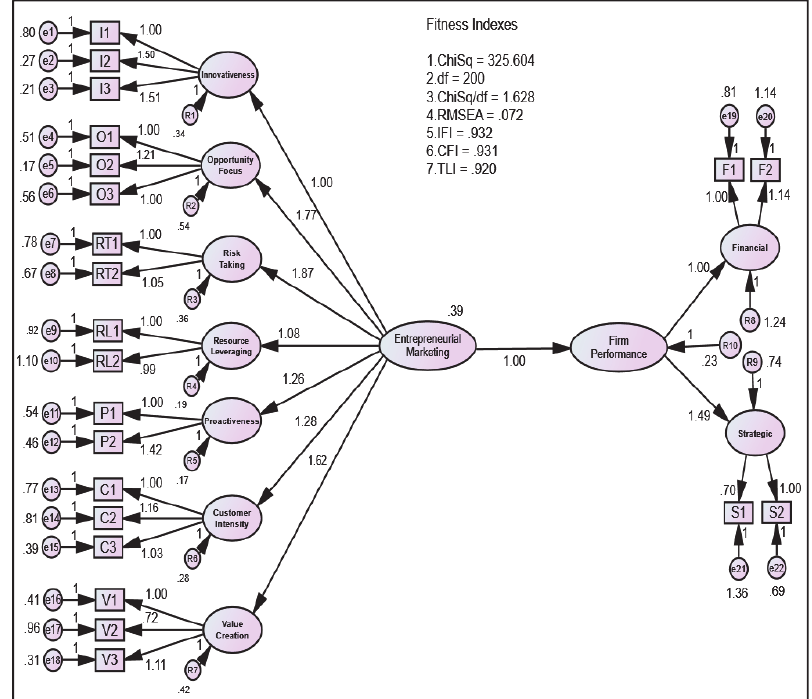
Fig. 5. M a le Group: Constrained Model Output Chi-Square Value and DF for Unc onstrained Model (Male Group) Model